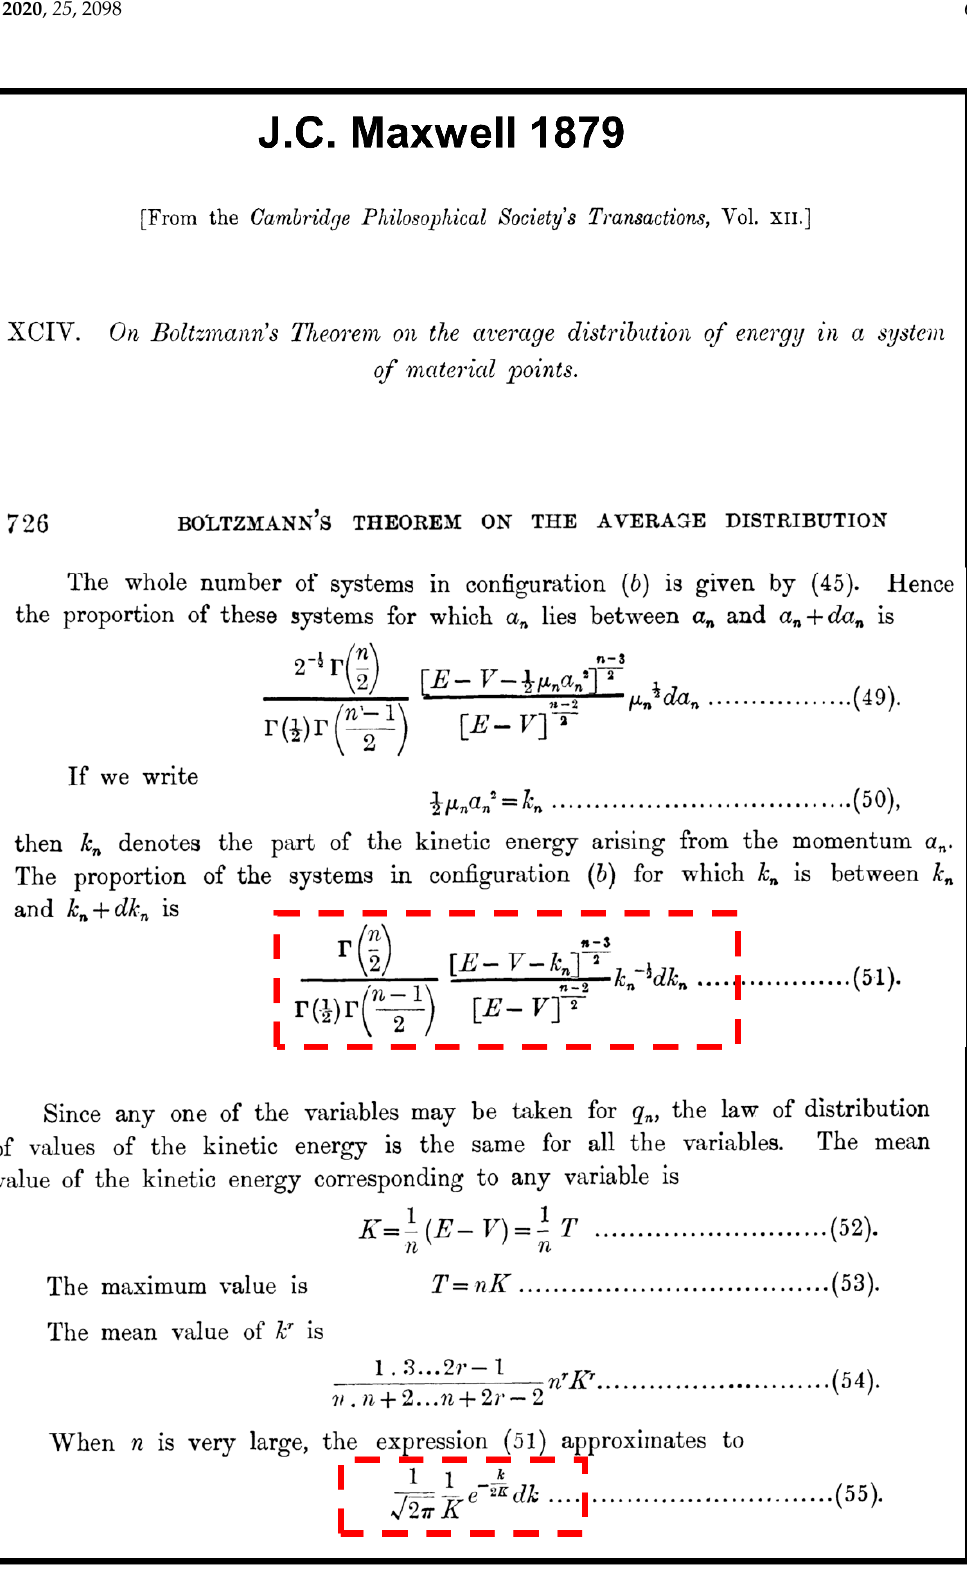
Figure 3. The later definitive formulation elaborating the Boltzmann derivation using the Euler formula for the exponential as the limit of a succession (Equation (51)), leading to continuous Equation (55). The equations are boxed in the Figure.